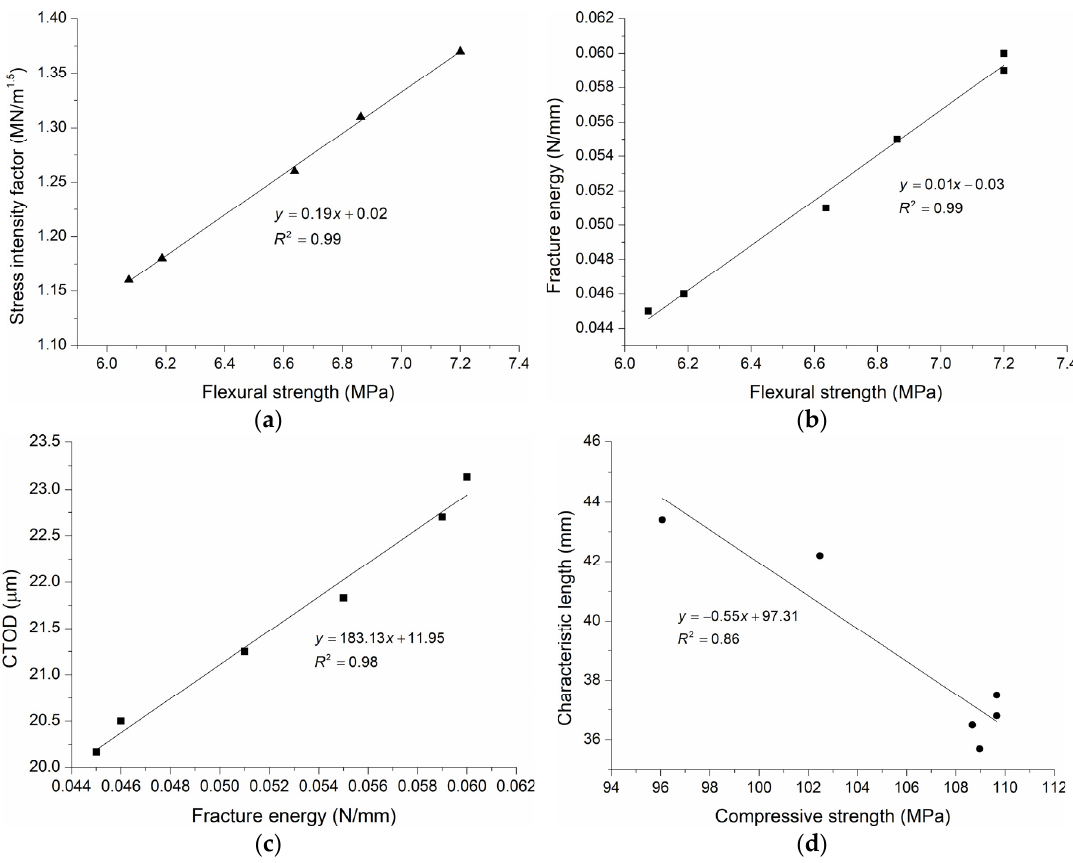
Figure 10. Correlation between ( a ) stress intensity factor and flexural strength; ( b ) fracture energy and flexural strength; ( c ) CTOD and fracture energy; ( d ) characteristic length and compressive strength, at 28 days.